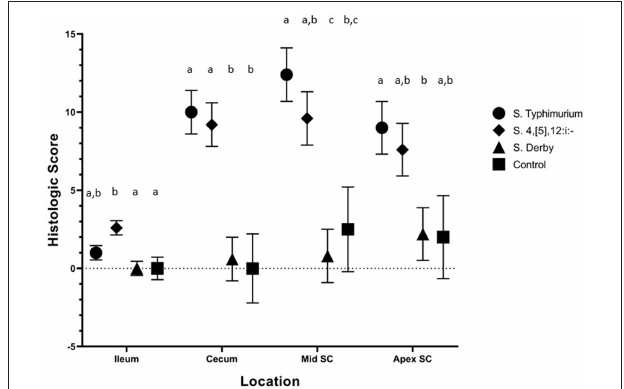
FIGURE 8 | Comparison of histologic lesion scores from pigs inoculated with Salmonella serovars 4,[5],12:i:-, Typhimurium, and Derby and non-inoculated control pigs in animal study #2. Histologic lesion scores represent a summary of the ulceration, neutrophil infiltration, crypt elongation and abscessation, and submucosal inflammation at the time of necropsy on DPI 2. Mean and standard error are represented by the symbols and vertical lines, respectively. Different letters indicate statistically significant differences between serovar groups, separated by tissue location ( p < 0.05). Histologic lesion scores from pigs euthanized on DPI 4 and 28 depicted in Supplemental Figure 2